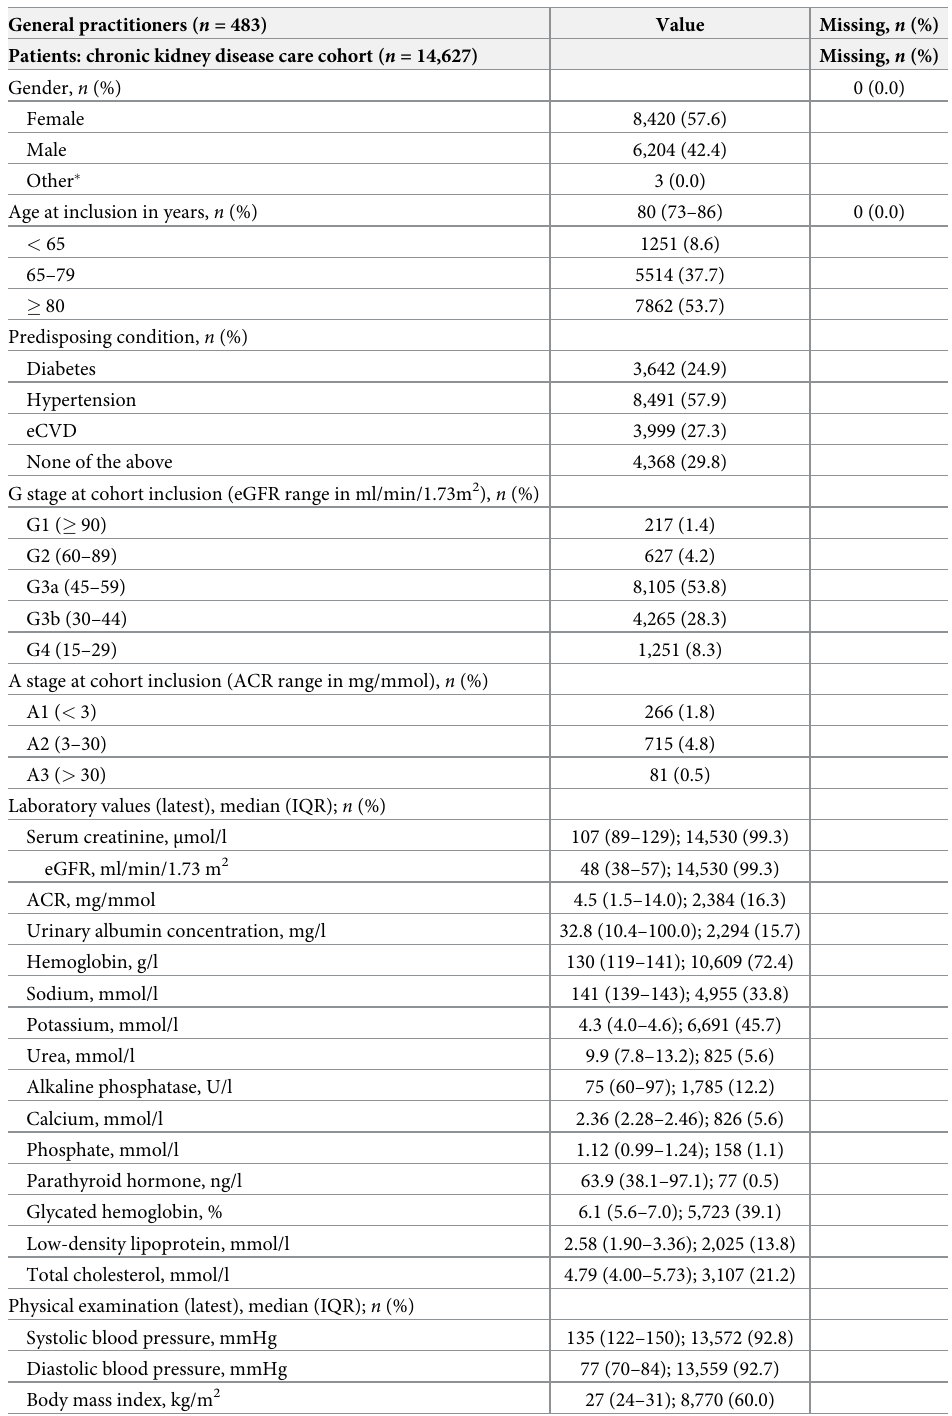
Abbreviations: ACR, albumin-to-creatinine ratio; eCVD, established cardiovascular disease; eGFR, estimated glomerular filtration rate; IQR, interquartile range.